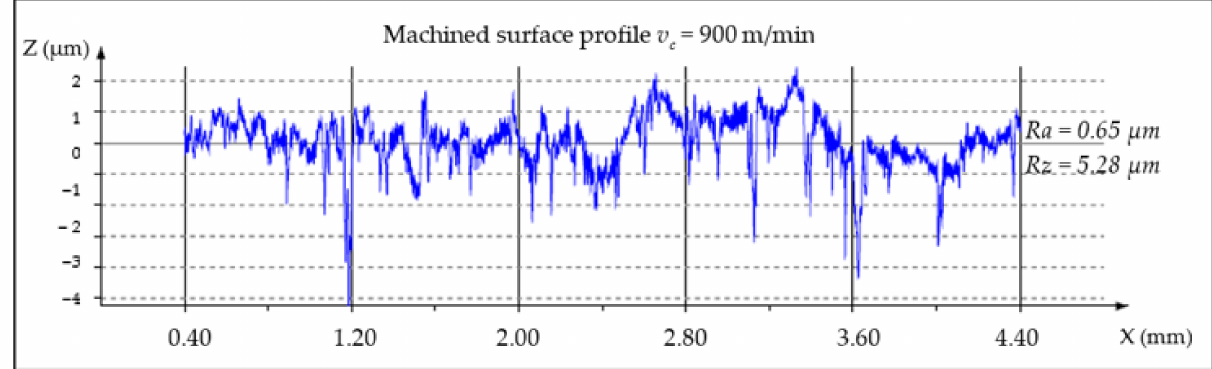
Figure 5. Machined surface profile of the AA359/SiC/10p, v c = 900 m/min, t c = 1.22 min. To present the measured value of surface roughness during the end milling of Duralcan TM , the Ra and Rz parameters in cutting time function are shown in Figures 6 and 7. The uneven rise of surface roughness could be caused by the unbalanced distribution of SiC particles in the matrix. As a result, the SiC particles are tearing from the matrix, and the machined surface quality is not satisfactory. Moreover, excessive tool wear causes microcracks and pits on the AMC surface. The relationship between the surface roughness, cutting speed, and tool corner wear ( VB C ) is presented in Figure 8.